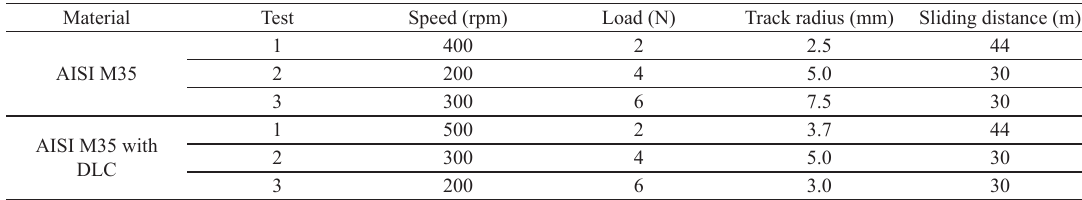
Table 2. Ball-on-disc sliding wear test conditions